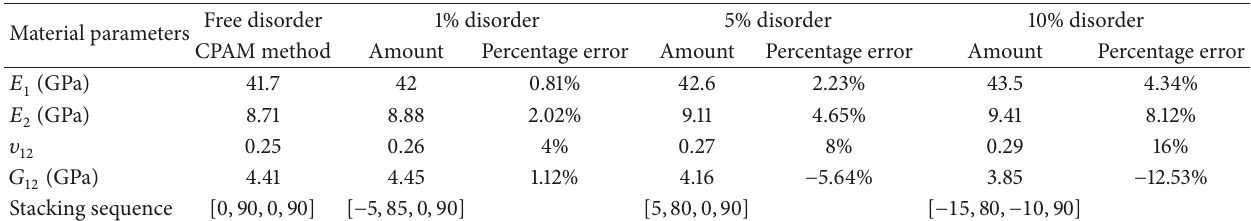
Table 12: Elastic constants determined for specimen C3 for different levels of